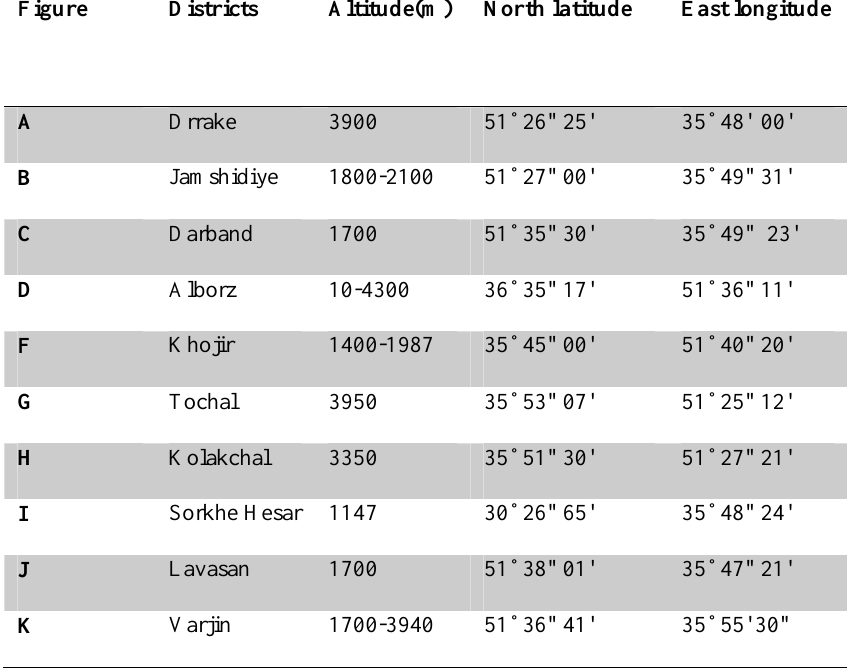
Table1. Collecting sites of Mantodea and their coordinates in southern part of Alborz Mountain. Figure Districts Altitude(m) North latitude East longitude